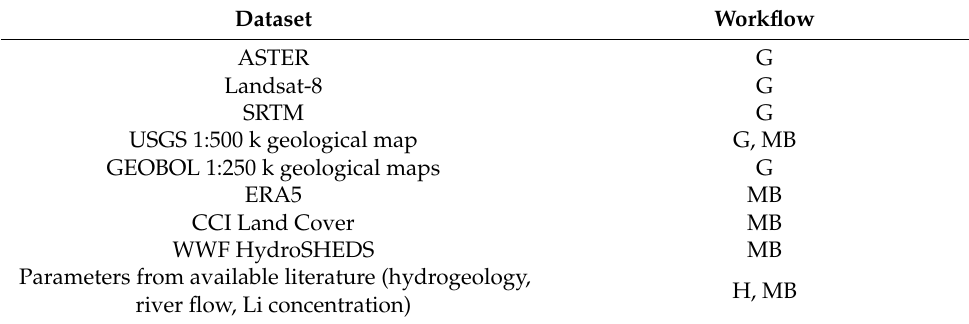
Table 1. Datasets used for the study (G = geology, H = hydrogeology, MB = mass balance). Dataset